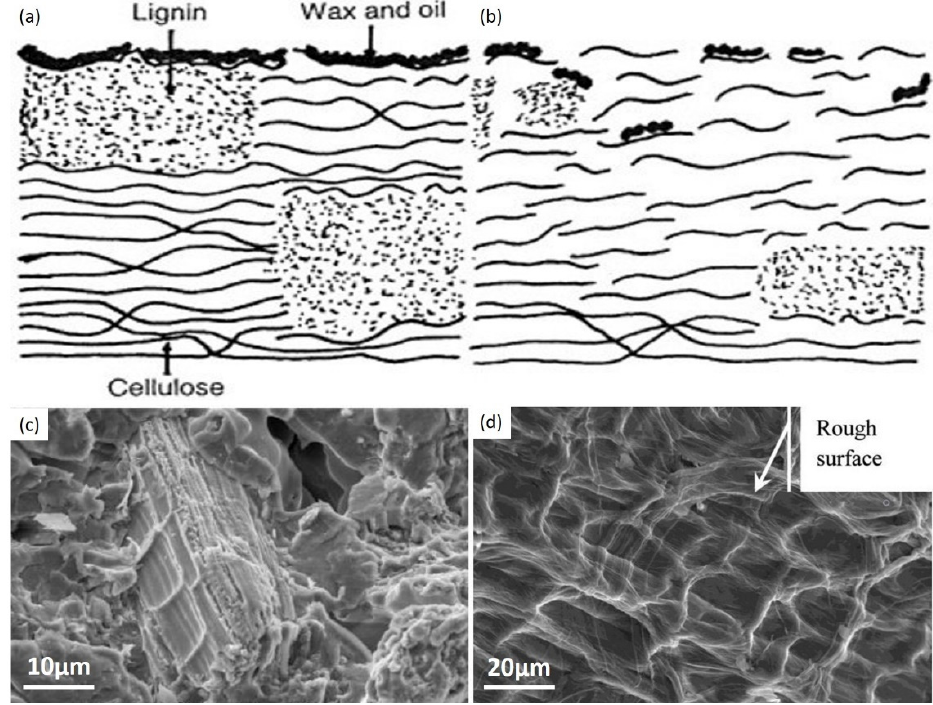
Figure 4. Demonstration of the difference between the pure kapok fiber ( a , c ) and ( b , d ) alkalized Kapok Fiber. Reprinted with permission from Ref. [75]. Copyright 2002, copyright John Wiley and Sons.